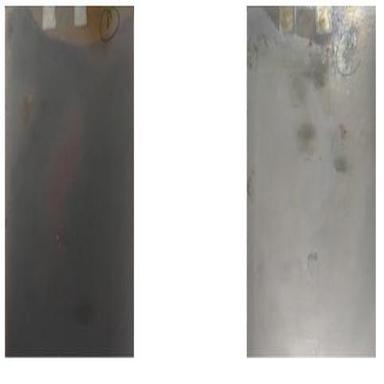
Macro photos of the heat-treated samples. a) oxidized sample, b) oxidized-reduced sample.